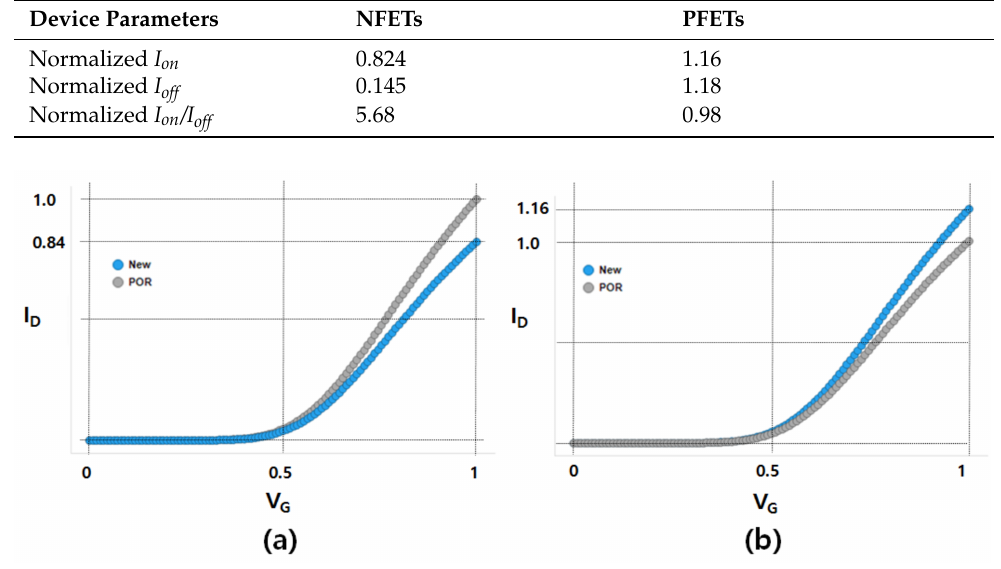
Figure 6. Measured input transfer characteristics of ( a ) NFET and ( b )